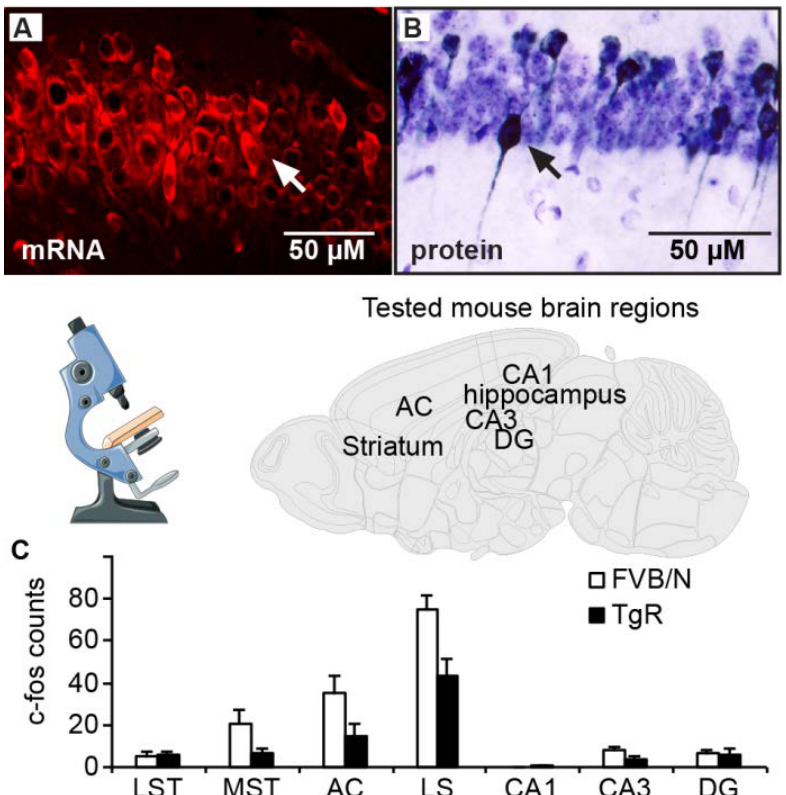
Figure 4. AChE-R shows hierarchical distribution in brain regions controlling motor behavior. ( A ) In FVB / N mice, subsets of CA1 neurons displayed higher than background expression of mouse AChE-R mRNA. ( B ) Neuronal activation (c-fos) patterns show inversed association to AChE-R. In the CA1 region of TgR mice, similar neuronal subsets expressed higher than background levels of the human AChE-R (hAChE-R) protein. ( C ) Using similar procedures, TgR mice presented lower basal level of neuronal activation reflected as c-fos staining in the dorsolateral striatum (LST), medial striatum (MST), anterior cingulate cortex (AC), lateral septum (LS) but not in hippocampal sub-regions CA1-2, CA3, and dentate gyrus (DG). Table 4. Neuronal c-fos activation in key structures of the emotional-motor interface. Brain